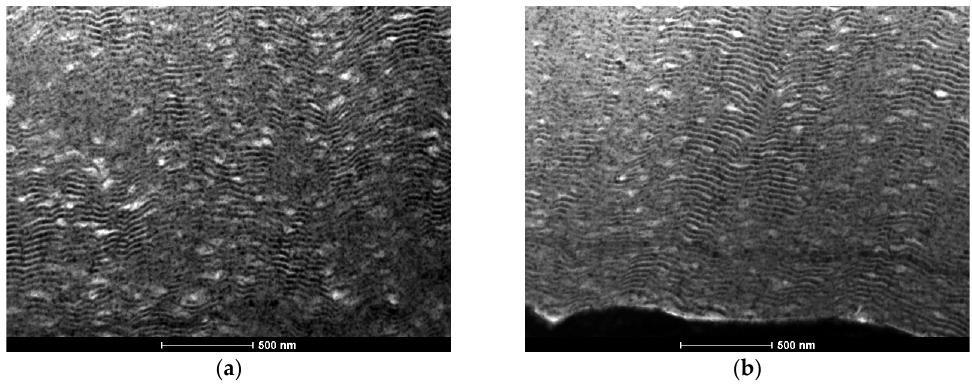
Figure 7. BF TEM cross-section micrographs of an Al/Ni thin film with Λ ≈ 35 nm, deposited using the new substrate holder (Figure 1). ( a ) bottom, and ( b ) top of the W wire ( φ = 0.05 mm).